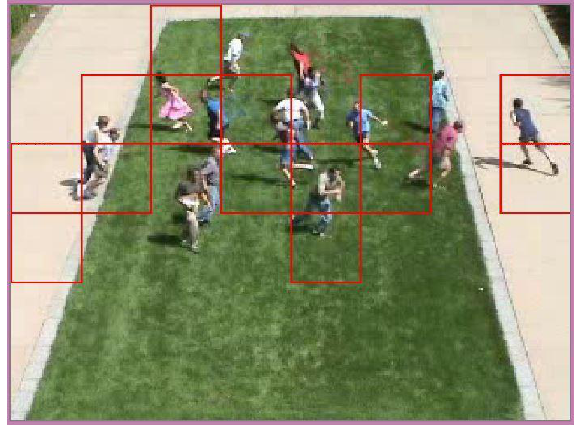
Figure 3. Abnormal activity is